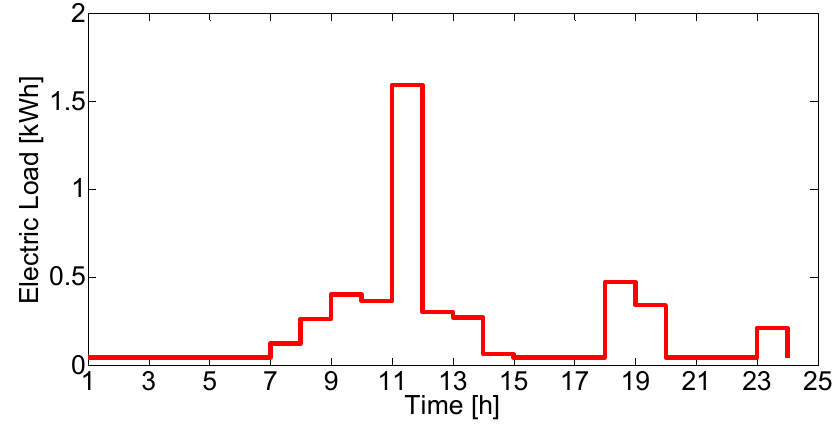
Figure 5. Electric load on a typical day during the year.